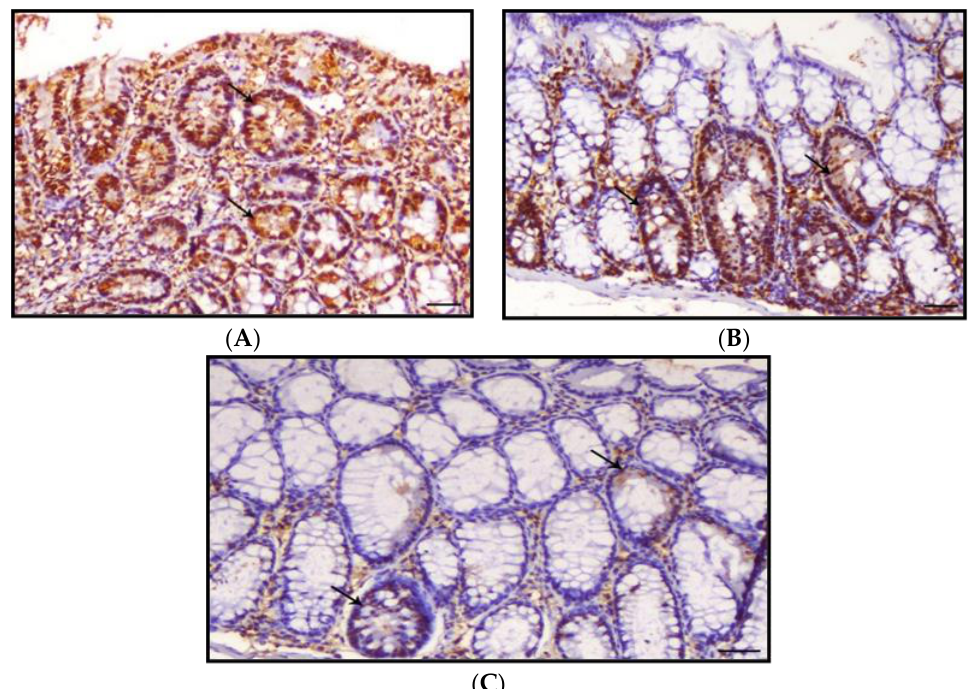
Figure 10. Photomicrographs of colon sections of mice stained IHC with PCNA; ( A ): Colon section of Group IV animals showing marked expression of PCNA within the intestinal crypts (arrows), PCNA IHC, ×200, bar = 50 μ m; ( B ): Colon section of Group V animals showing a slight decrease in expression of PCNA within the intestinal crypts (arrows), PCNA IHC, ×200, bar = 50 μ m; ( C ): Colon section of Group VI animals showing marked decrease in the expression of PCNA within the intestinal. Crypts (arrows), PCNA IHC, ×200, bar = 50 μ m.